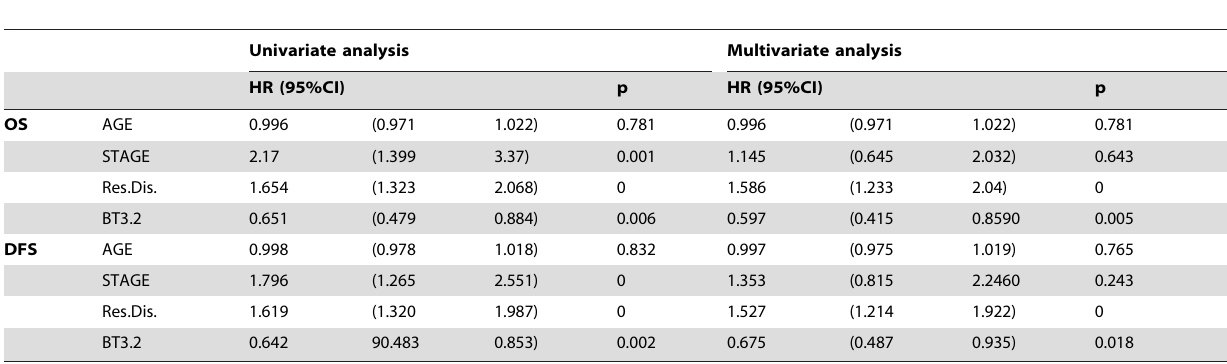
Table 3. Univariate and multivariate Cox regression analysis showing the statistical association between BT3.2 expression and outcome of EOC